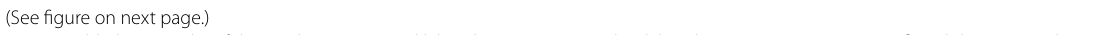
Fig. 9 Field photographs of the April ROS-triggered lahar deposits. MF: October lahar deposits, p.e.: pre-eruptive fluvial deposits, and ROS: April lahar deposits. a Retreated bank (arrow) showing high erosional character of the lahar flow. b Exhumed pre-eruptive terrace deposits and the October lahar deposits. c The ROS lahar terrace (Loc. 1227) developed into the October lahar deposits overlying the pre-eruptive fluvial deposits. d Close-up of c . e Massive to very crudely stratified ROS deposits indicative of hyperconcentrated flow deposition (Loc. 1229). f Thin ROS lahar deposits (overbank facies) overlying the October lahar deposits (Loc. 1199). g Distal end of the ROS deposits. The deposits are well sorted and parallel laminated